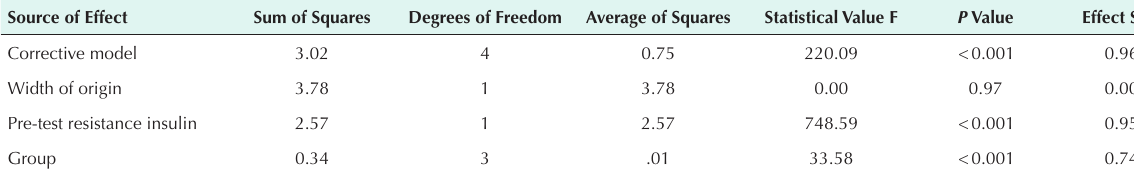
Table 5. Results of the Analysis of Covariance to Evaluate the Effect of Exercise Interventions on Insulin Resistance Levels